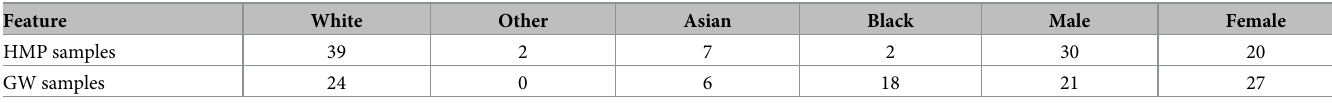
Table 1. Human Microbiome Project (HMP) and GW participant